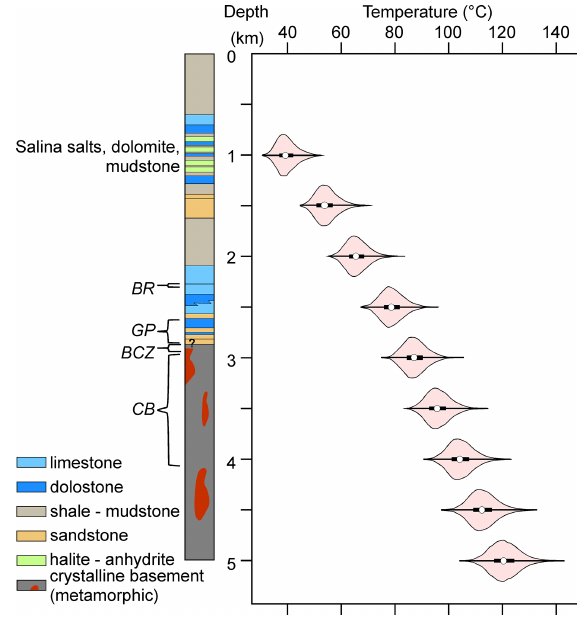
Figure 2. Left: approximate geological column near Ithaca, NY. Paleozoic sedimentary rocks extend to about 2850m depth ± 200m, underlain by metamorphic basement. Targeted intervals to probe for their geothermal reservoir conditions are indicated by brackets, cor- responding to the BR (Black River), GP (Galway and Potsdam), BCZ (basement contact zone), and CB (crystalline basement). Cut- tings from 46m (150ft) penetration into the basement by a borehole 10km south of Cornell indicate a hydrothermally altered granitic to monzonitic gneiss (Benjamin R. Valentino, unpublished data, 2016). Near Cornell’s campus, xenocrysts in kimberlites are very rich in Mg, suggestive of granulite-grade marble in the upper base- ment (Kay et al., 1983). Right: predicted temperature–depth pro- file below Cornell University in Ithaca, NY, based on geostatistical interpolation of the surface heat flow as estimated from corrected borehole temperatures in the Appalachian Basin near Ithaca, utiliz- ing 10000 Monte Carlo replications to incorporate the uncertainty in geologic properties and heat flow estimates (Smith, 2019). The uncertainty distribution of predicted temperatures for each 0.5km depth interval is shown as a pale red violin plot (kernel density plot). White circles are placed at the median predicted temperature at each depth, and a narrow black box in the center spans the 25th to 75th percentile